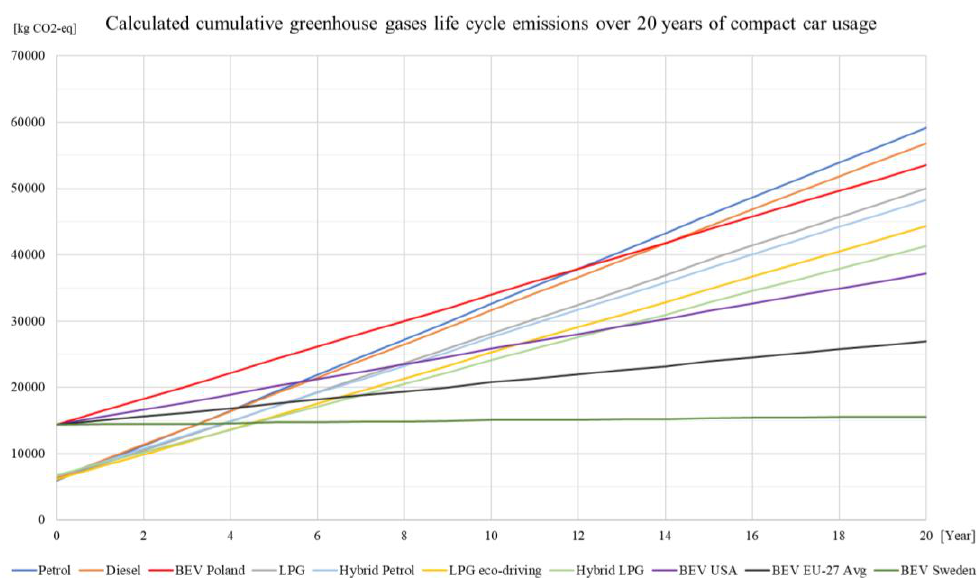
Fig. 2. Calculated cumulative greenhouse gases life cycle emissions over 20 years of compact car